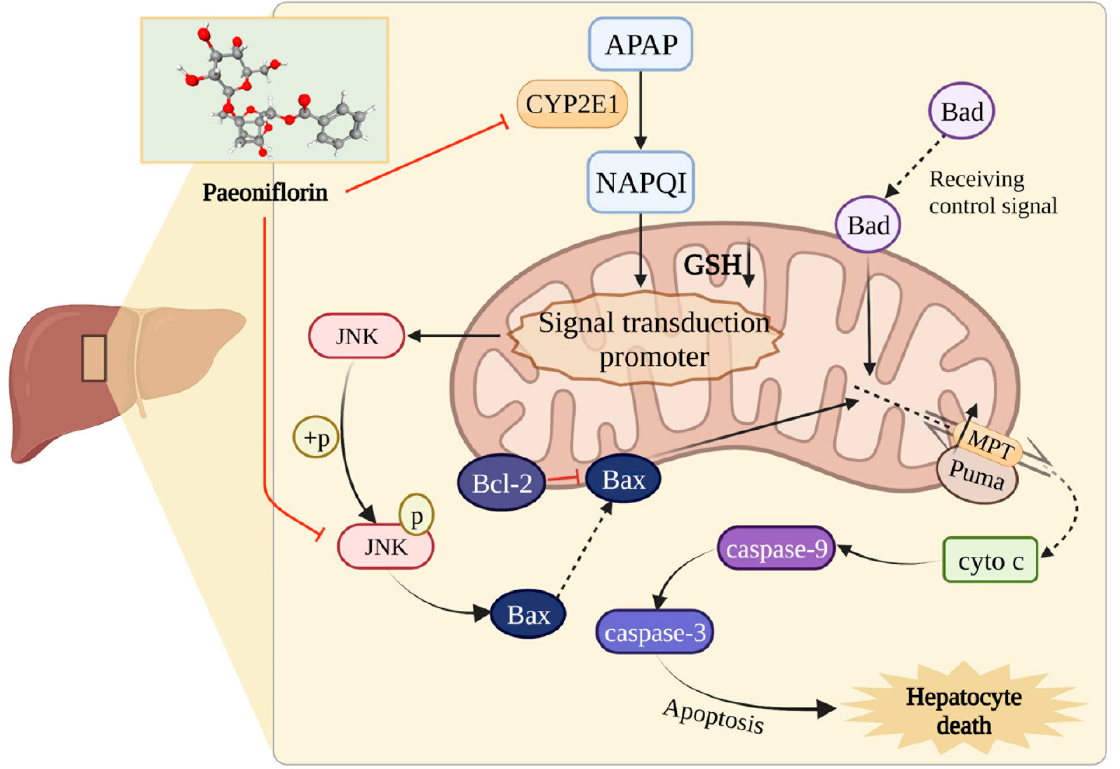
Figure 9. The mechanism diagram of PF on APAP-induced liver injury. The solid arrows show the metabolic course of APAP. The dotted arrows represent translocation of proteins. And the red arrows indicate inhibition of paeoniflorin.